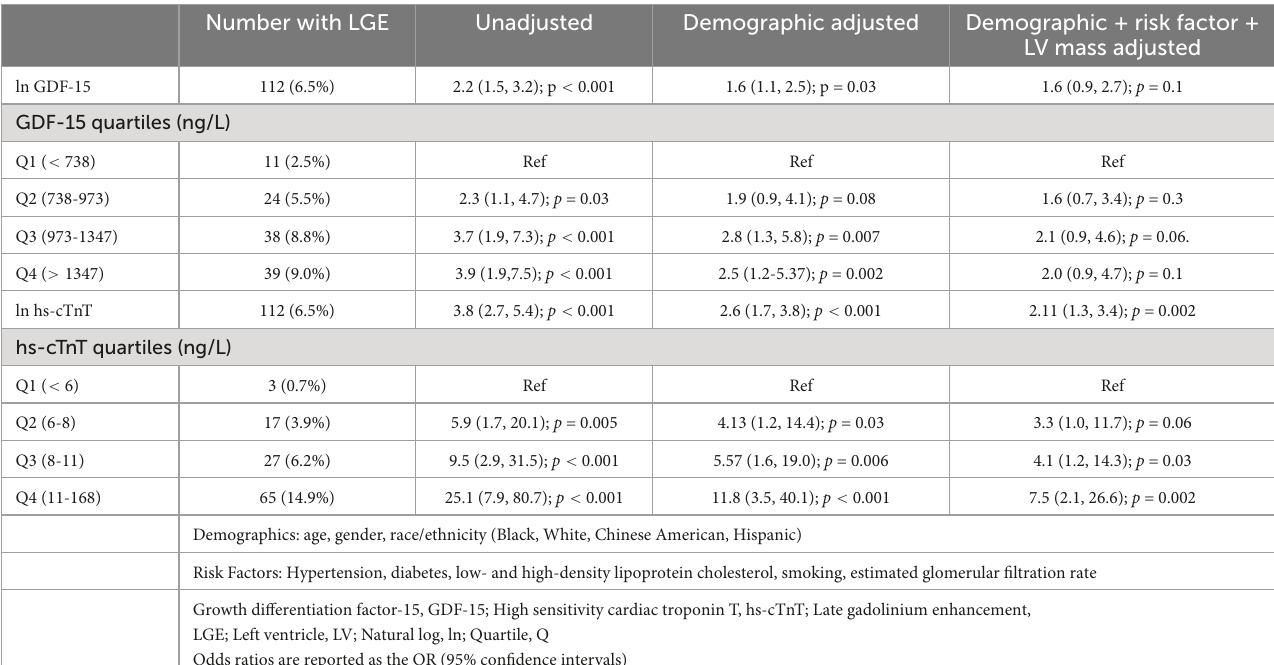
TABLE 3 Association (odds ratios) of GDF-15 and hs-cTnT with interstitial fibrosis (highest quartile % ECV) ( n = 1258). % with high ECV Unadjusted Demographic adjusted Demographic + risk ln GDF-15 1.5 (1.1, 1.9); p =